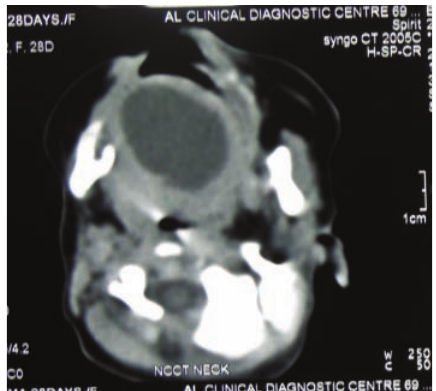
Figure 3: CT scan showing the cystic lesion in the axial cut.